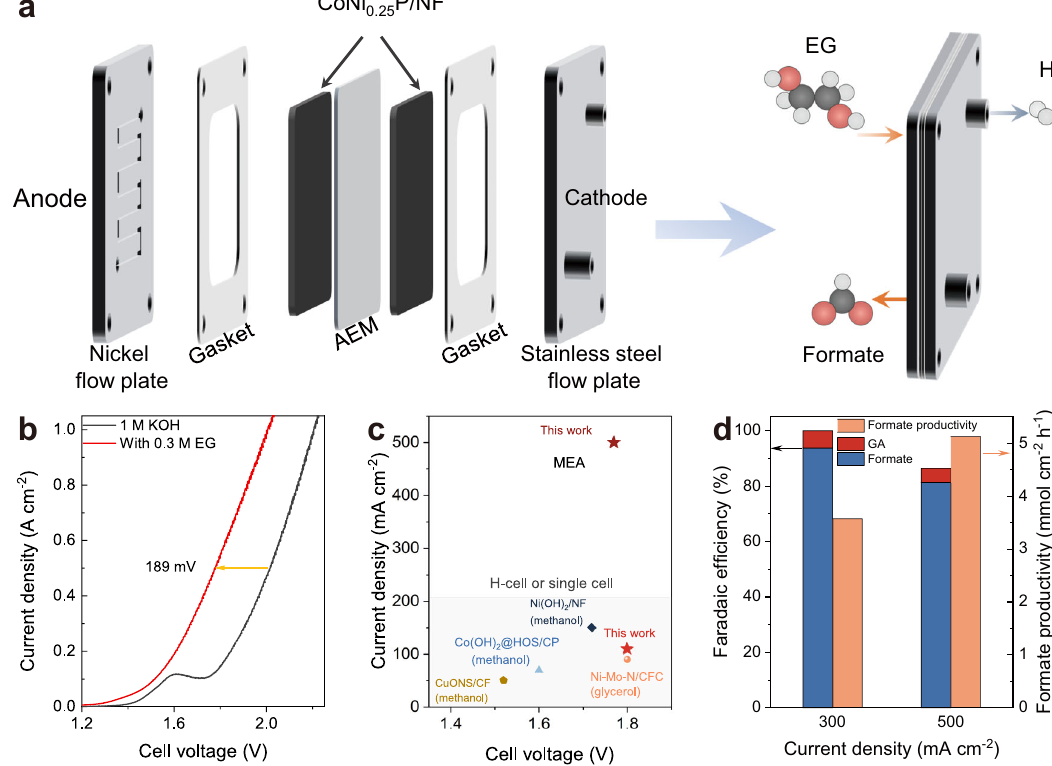
Fig. 3 Membrane-electrode assembly (MEA) for EG oxidation. a The MEA setup for paired HER( − )//EG oxidation( + ). b Polarization curves for water splitting and EG electrolysis in the MEA fl ow reactor at a scan rate of 10 mV s − 1 . c Current density for formate production as a function of cell voltage in literatures and this work. d Faradaic ef fi ciency and productivity as function of current density for EG